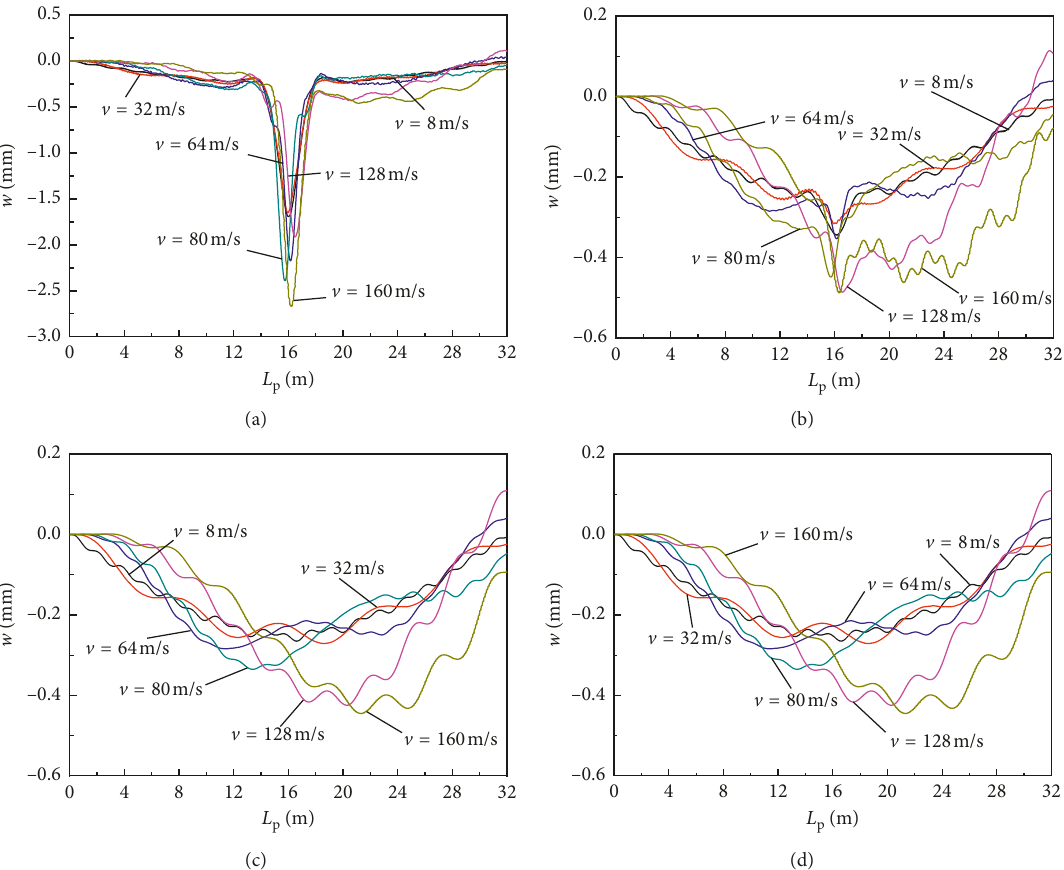
Figure 4: Dynamic deflections of rail, track plate, base plate, and bridge under different train speeds. Deflection of (a) rail, (b) track slab, (c) bed plate, and (d) bridge.